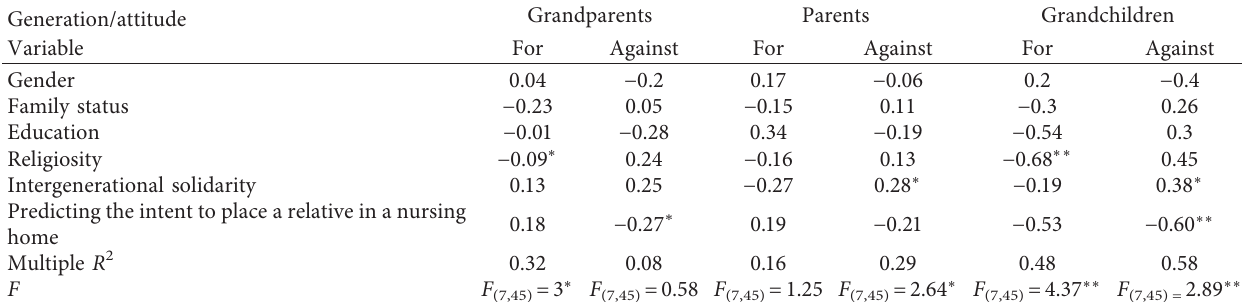
Table 3: Multiple regression analysis measuring the contribution of the research variables attitude for or against nursing home placement.